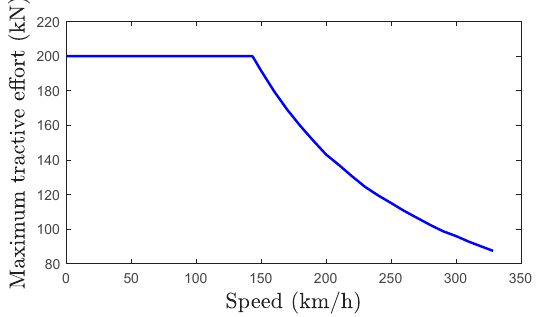
Figure 2. Maximum tractive effort curve for the considered Talgo-Bombardier class 102 train.